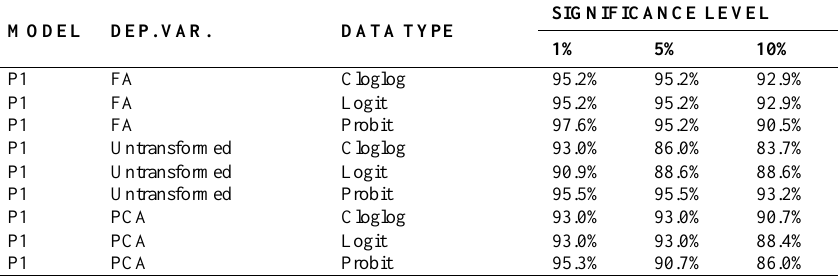
Table 2. The Hosmer-Lemeshow test results for the individual assets analysis